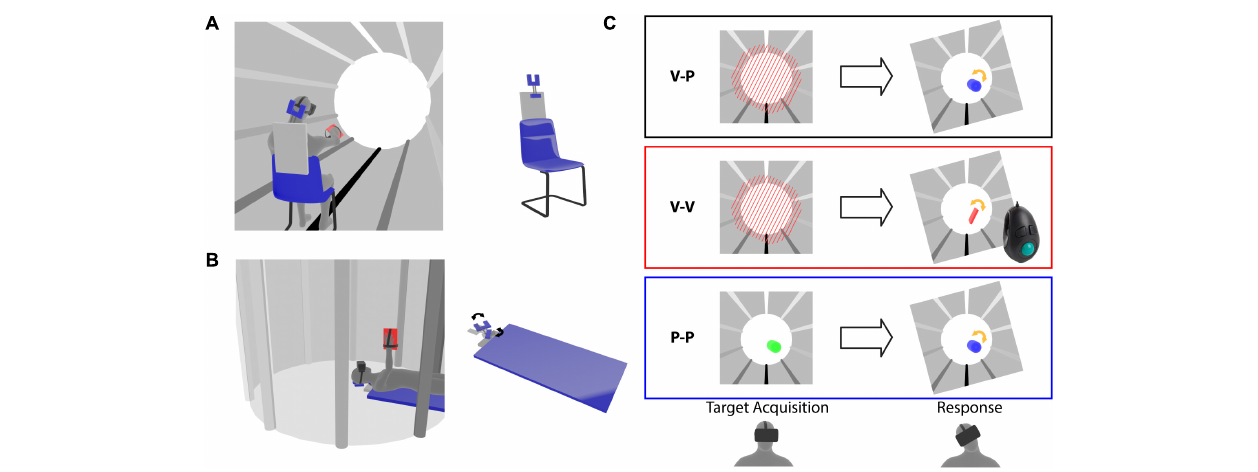
FIGURE 1 | Virtual reality experimental paradigm. Representation of the (A) Seated and (B) Supine conditions. The subjects wear a virtual reality headset and a tool is fixed to their hand. The left images illustrate the virtual tunnel in which the subject perform the task. The configuration of the rotating head support (forked structure) is shown for the two postural conditions. (C) Target presentation (left) and response modality (right) for the three experiments. The tilted frames in the response phase represent the lateral neck flexion that the subjects perform after the target memorization. For the cross-modal (V-P) task the target is represented by tilted red bars and during the response the subject hand movements are applied to a blue capsule, which provides visual feedback about the pointing direction in pitch and yaw, but no visual cues about the prono-supination of the hand used to reproduce the target orientation. For the unimodal visual (V-V) task the target is presented as in the V-P task, but a virtual hand-tool (red rectangle) controlled by a trackball is used to reproduce the target orientation. During the target acquisition of the unimodal proprioceptive (P-P) task the color of the capsule representing the subject hand changes from red to green when the hand approaches the target orientation. The response modality is the same as in the V-P